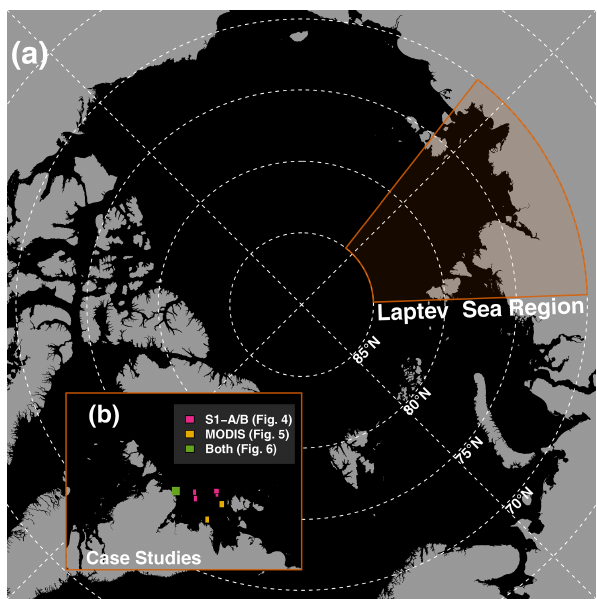
Figure 1. Overview of the study area within the Arctic Laptev Sea region (a ; orange outline ) . Small rectangles within the map inlet (b) mark the locations of case studies used in this study (see Figs.